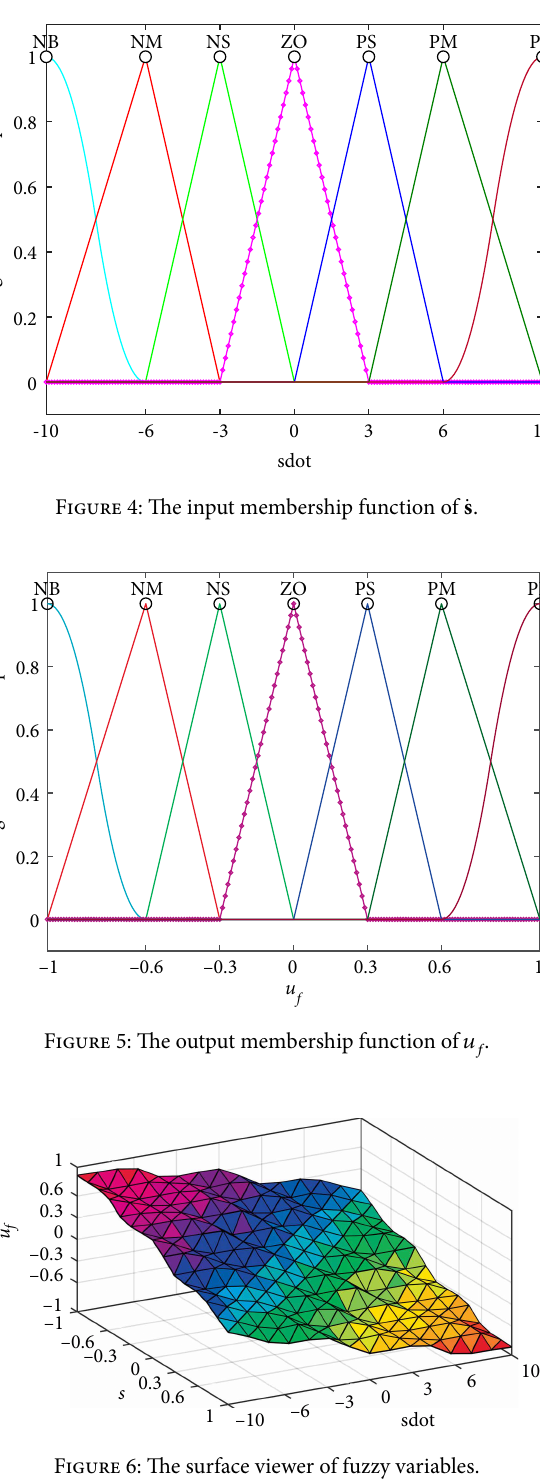
Figure 6: The surface viewer of fuzzy